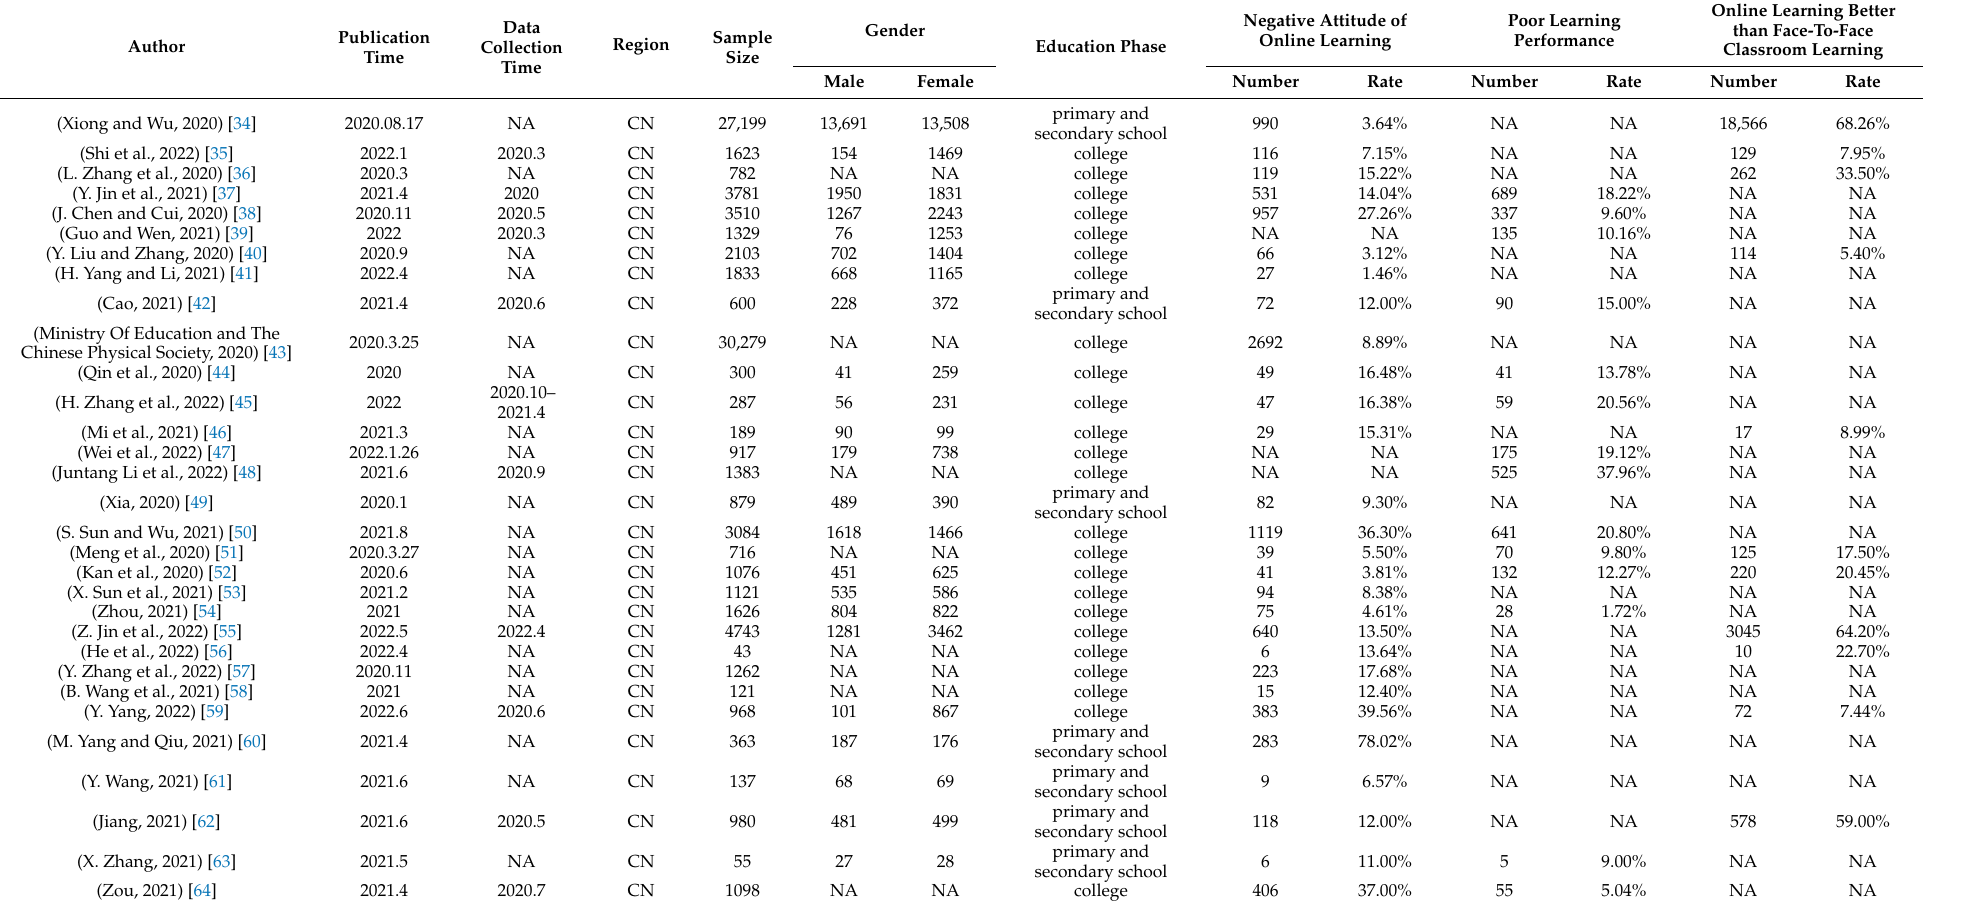
Table 1. Summary of characteristics of included studies. N.A. = not